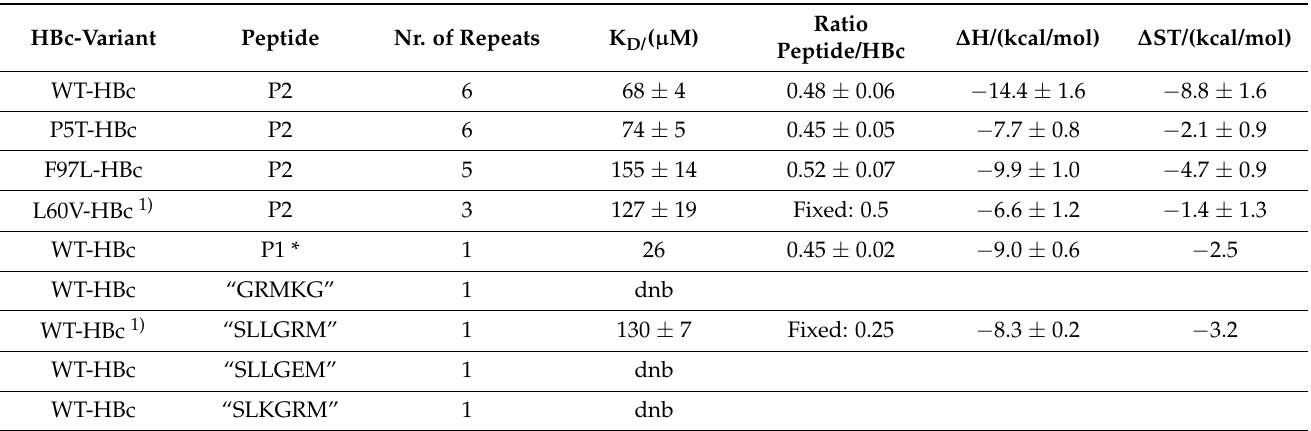
Table 1. Thermodynamic characterization of the interaction between P2, P1, “SLLGRM”, “SLLGEM”, “SLKGRM” and “GRMKG” with different HBc